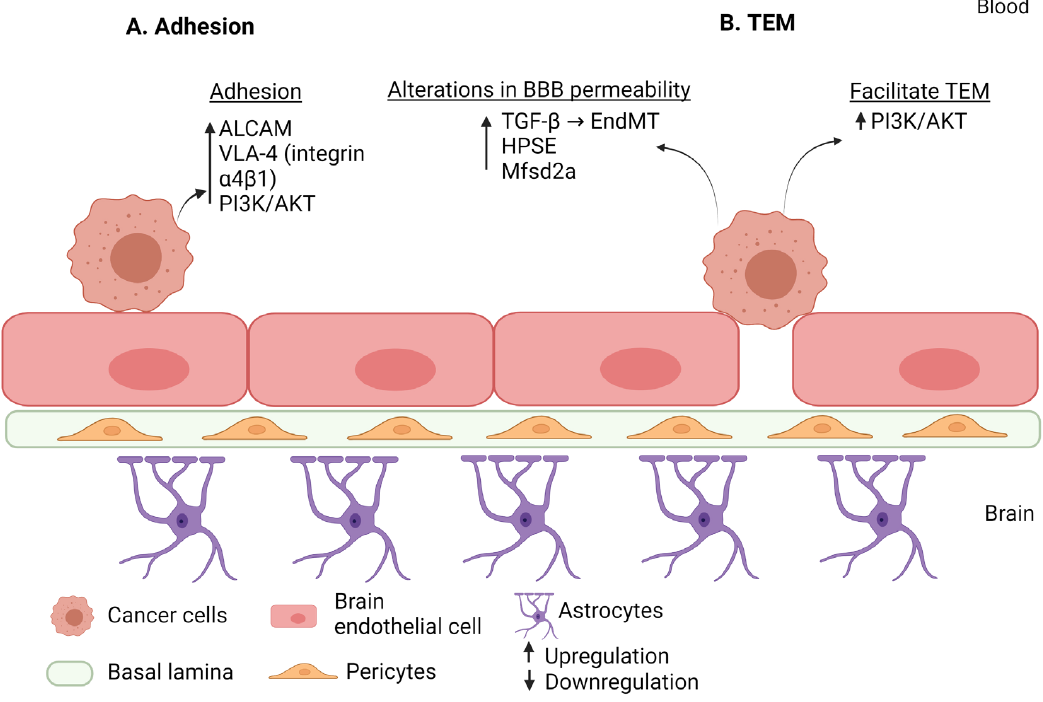
Figure 4. Schematic representation of common mediators of extravasation in the different types of tumors. ( A ) Adhesion: ALCAM is a common adhesion molecule used by both breast and lung cancer cells, while VLA-4 and the PI3K/AKT signaling are used by breast cancer and melanoma cells to promote adhesion [28,130]. ( B ) Trans-endothelial migration: Breast cancer and melanoma cells enhance the BBB permeability through upregulation of HPSE and TGF- β 1 and activation of EndMT, while Mfsd2a is a common mediator used by breast and lung cancer cells to induce alterations in the endothelial barrier [53,108]. TEM is commonly mediated by PI3K/AKT in breast cancer and melanoma cells [74]. Photo created with BioRender.com.